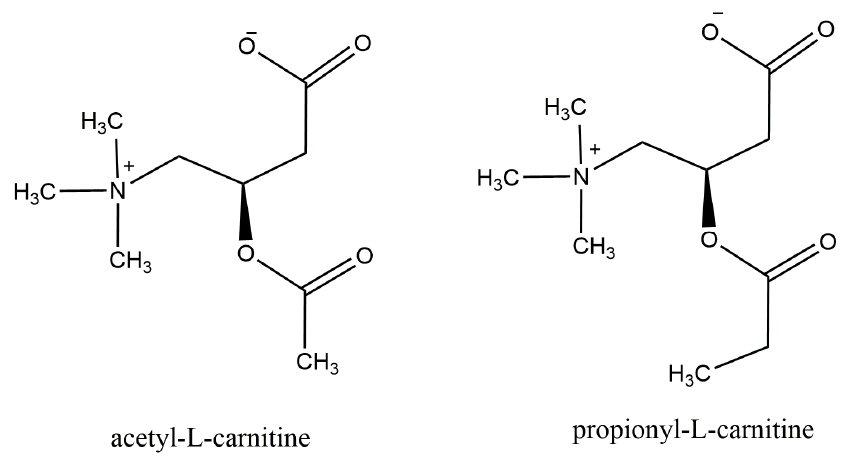
Figure 2. Chemical structure of acetyl- L -carnitine and propionyl- L -carnitine.